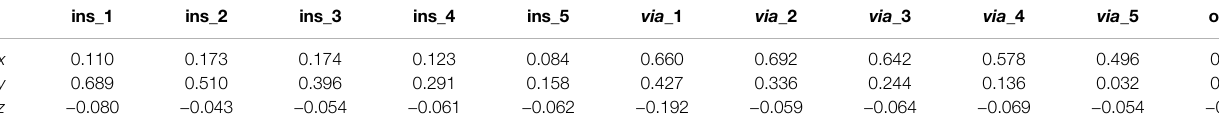
TABLE 4 | Size-normalized position vectors of the insertions, via points, and origins of the plantar aponeuroses.